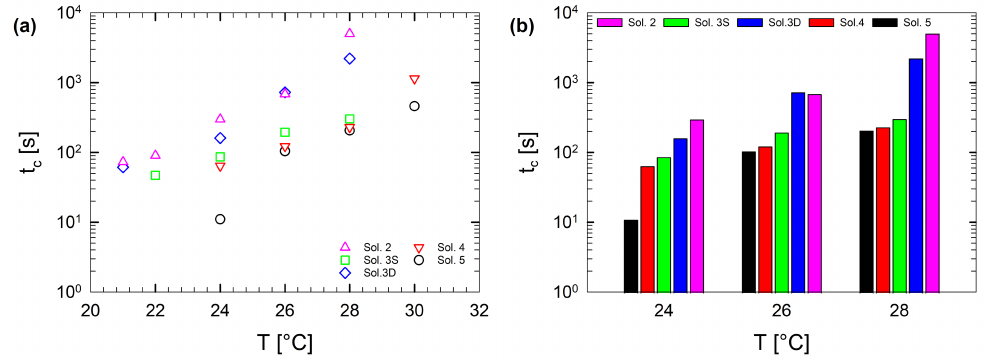
Figure 8. Temperature dependence of the gel time, t c : ( a ) For the entire temperature range explored and ( b ) only for three selected temperatures.